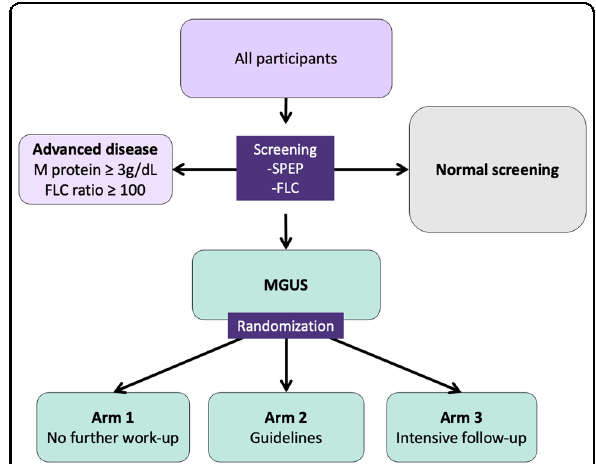
Fig. 2 A fl owchart outlining the study design for screening and randomization of individuals with MGUS. MGUS Monoclonal gammopathy of undetermined signi fi cance, SPEP Serum protein electrophoresis, FLC Free light chain assay, SMM Smoldering multiple myeloma, MM Multiple